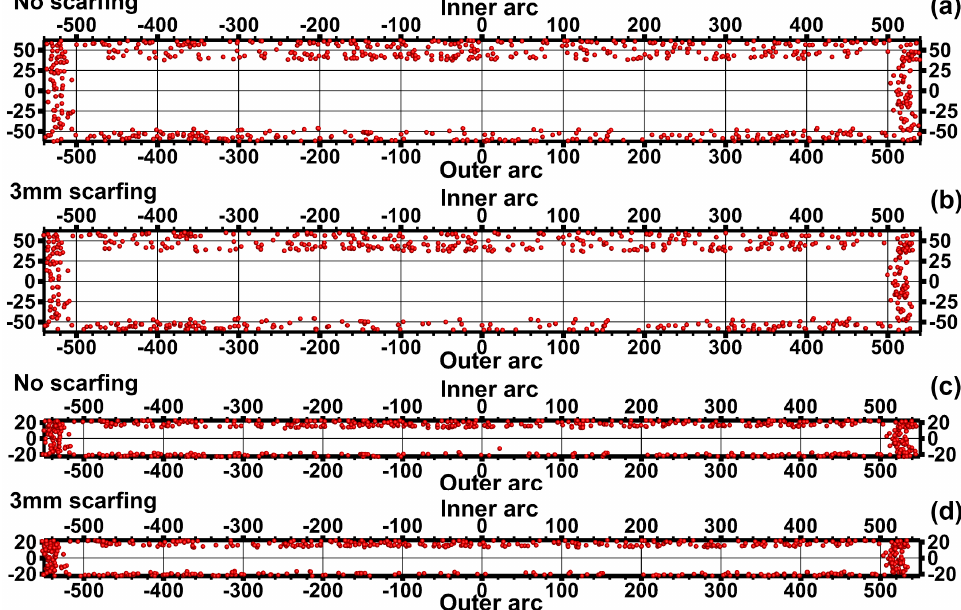
Figure 8. The distributions of inclusions in the intermediate slab after R2-1 pass ( a , b ) and R2-5 pass ( c , d